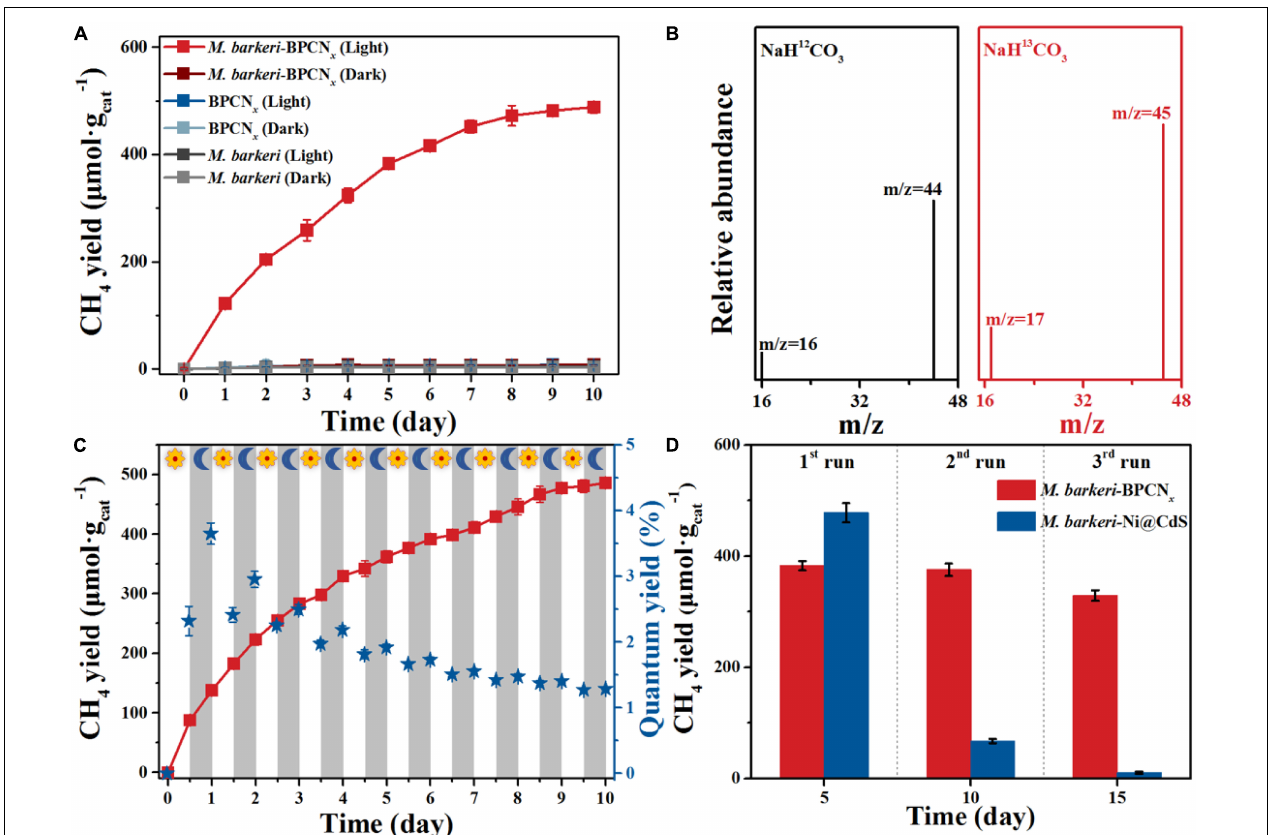
FIGURE 4 | Utility of M. barkeri -BPCN x in the photoreduction of CO 2 to CH 4 . (A) CH 4 yield of M. barkeri -BPCN x and control groups. (B) C-labeled plot. (C) CH 4 yield of M. barkeri -BPCN x with light:dark cycles of 12 h. (D) Multi-cycle CH 4 yield of M. barkeri -Ni@CdS and M. barkeri -BPCN x